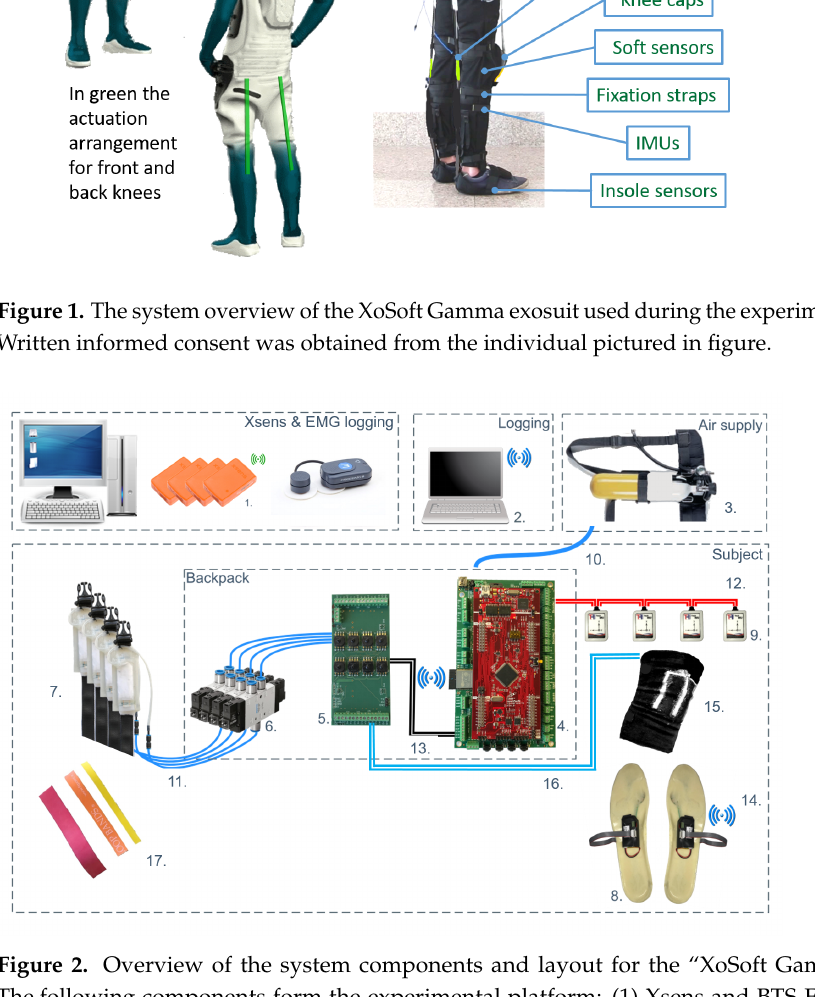
Figure 2. Overview of the system components and layout for the “XoSoft Gamma prototype”. The following components form the experimental platform: (1) Xsens and BTS-EMG logging for motion tracking sensors and EMG recording; (2) Logging controller for the exoskeleton state mea- surement sensors; (3) Air supply; (4) Central processor; (5) Valve controller board; (6) Valves; (7) Soft Clutches (SCs); (8) Shoe sensors; (9) IMUs; (10) Compressed air; (11) Vacuum lines; (12) CAN bus 1; (13) CAN bus 2; (14) Wi-Fi network 1; (15) soft sensors; (16) CAN bus 3; (17) Elastic Bands (EBs). Main hardware components of the exoskeleton are described in Section